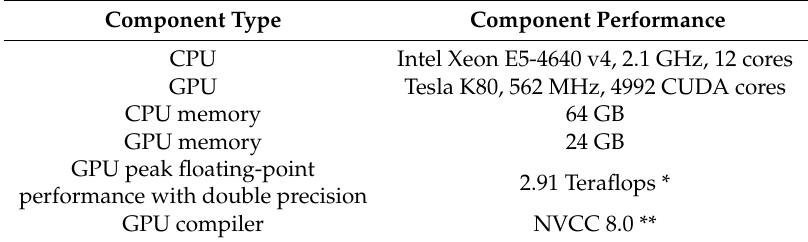
Table 3. Hardware